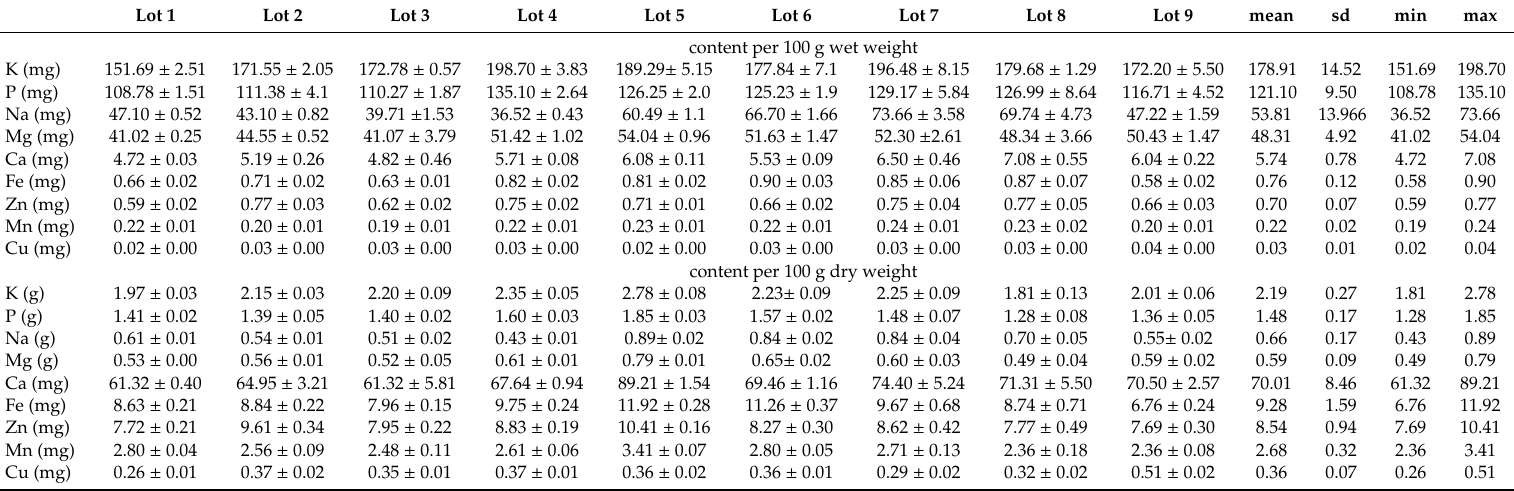
Table 4. Minerals and trace element contents of thin stillage from the dry-grind corn ethanol plant. Mean, standard deviation, and range of values observed over a one-year period (n =